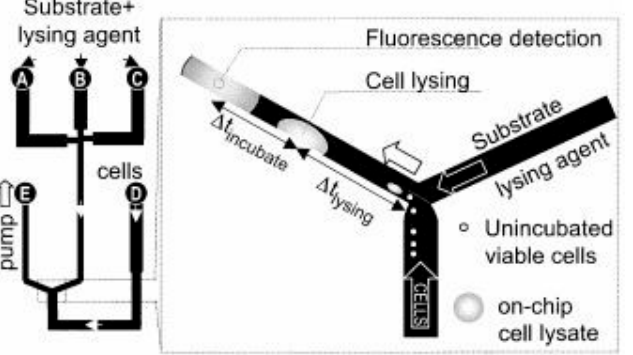
Figure 5. Scheme of the on-chip lysing and on-chip incubation of HL-60 cell with substrate devel- oped in [20]. A fluorescence detector was located downstream of the mixing point, and an observa- tion microscope sat over the intersection. Adapted with permission from [20]. Copyright 2004 Copyright IEEE.